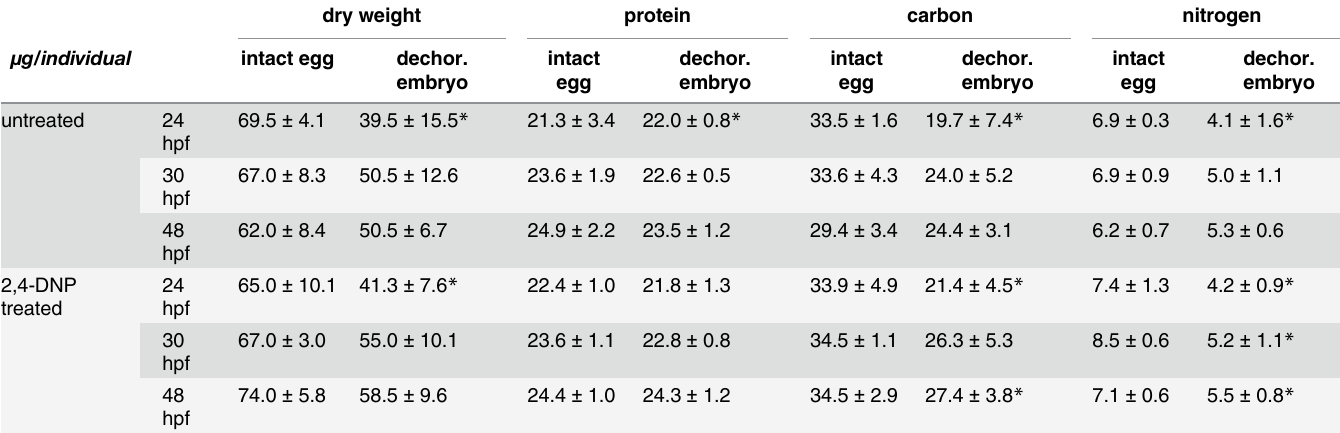
Table 1. Mean values for dry weight and the amounts of protein, carbon and nitrogen ( ± STD) for intact zebrafish eggs and embryos without cho- rion at 24, 30 and 48 hpf. Values are listed for untreated embryos and embryos that had been exposed to 2,4-DNP. Values for dechorionated embryos that were statistically significantly different from eggs with chorion from respective treatments (2,4-DNP exposure or control) are marked with * (p < 0.05; Stu- dent ’ s t-test). Note that values for untreated intact eggs correspond to respective data presented in Fig 1 and were listed here for comparison. For dry weight, carbon and nitrogen: n = 4 with 5 pooled individuals per n; for proteins: n = 5 – 7 with 30 pooled individuals per n; hpf: hours post fertilization.